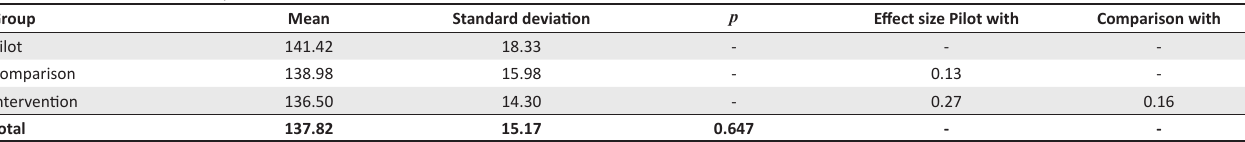
TABLE 2: Results of ANOVA on pretest of resilience – Cohen’s d coefficient. Group